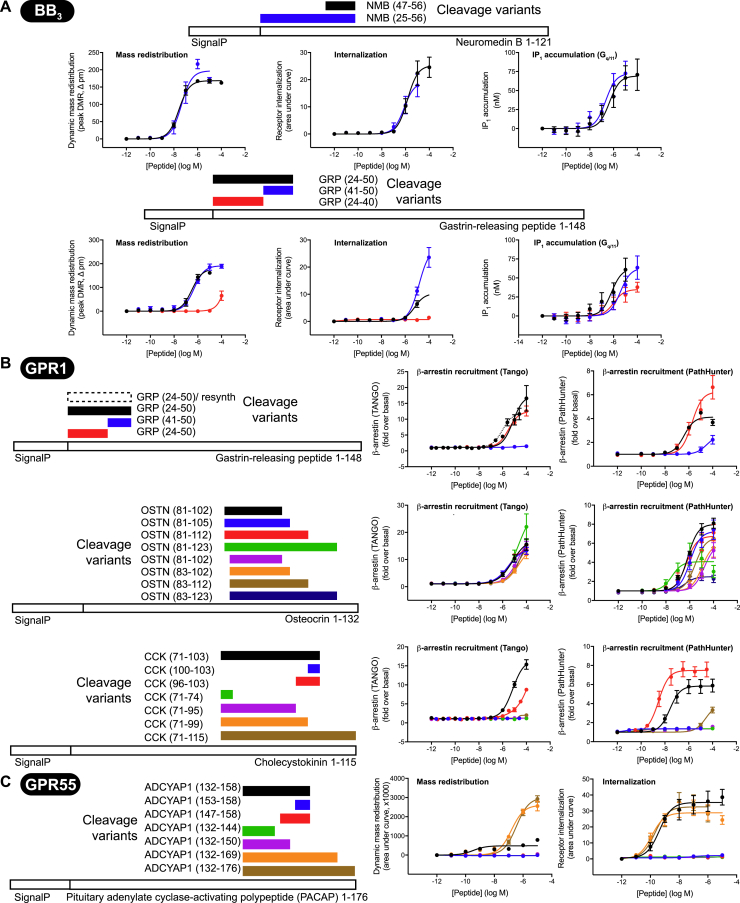
Peptide Ligand Variants Elicit Differential oGPCR Signaling Responses, Related to Figure 5(A) BB3 responses for neuromedin B (NMB) and gastrin-releasing peptide (GRP) cleavage variants.(B) GPR1 responses for gastrin-releasing peptide, osteocrin (OSTN) and cholecystokinin (CCK-33) cleavage variants.(C) GPR55 responses for PACAP cleavage variants. Mass redistribution data show an apparently biphasic response for PACAP peptides, which could indicate an additional intracellular signaling pathway mediated via GPR55. Numbers in parenthesis indicate positions in the full-length protein.All data represent mean ± SEM for n = 3-4 independent experiments performed in triplicate.